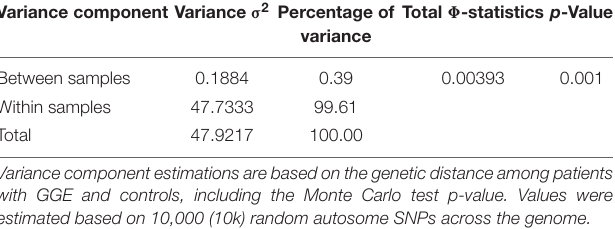
Frontiers in Genetics |